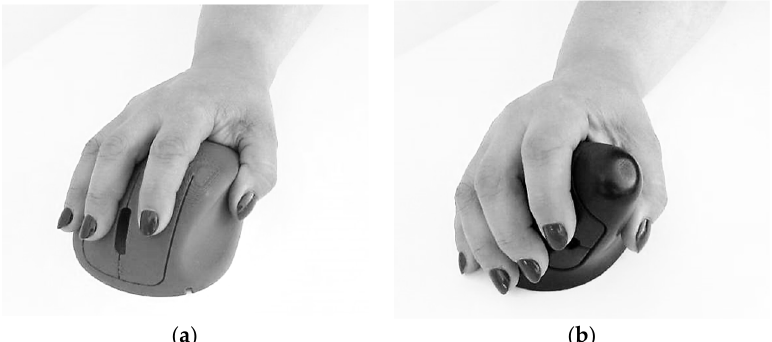
Figure 5. Concept mockups (female adult hand, length 165 mm, width 74 mm, corresponding respectively to 5 th and 15 th percentile, according to Gordon et al. [26]). ( a ) ch concept mockup; ( b ) ci concept mockup.